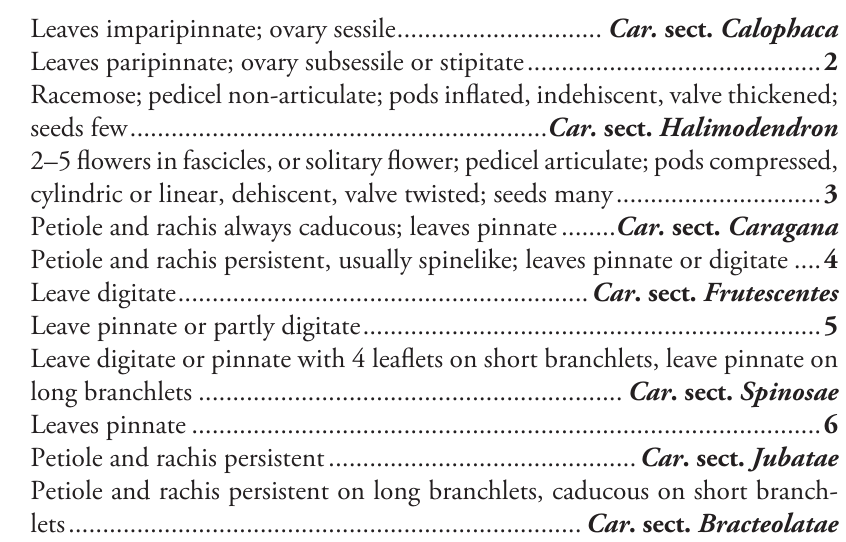
Fig. 3B–D Spongiocarpella Yakovlev & N.Ulziykhutag, Bot. Zhur. 17(2): 249. 1987. syn. nov. Type: Spongiocarpella nubigena (D.Don) Yakovl., Bot. Zhur. 17(2): 249. 1987, based on Chesneya nubigena (D.Don) Ali. (see blow) Type. Chesneya rytidosperma Jaub. et Spach, Ill. Pl. Orient. 1(5): 93. 1842.